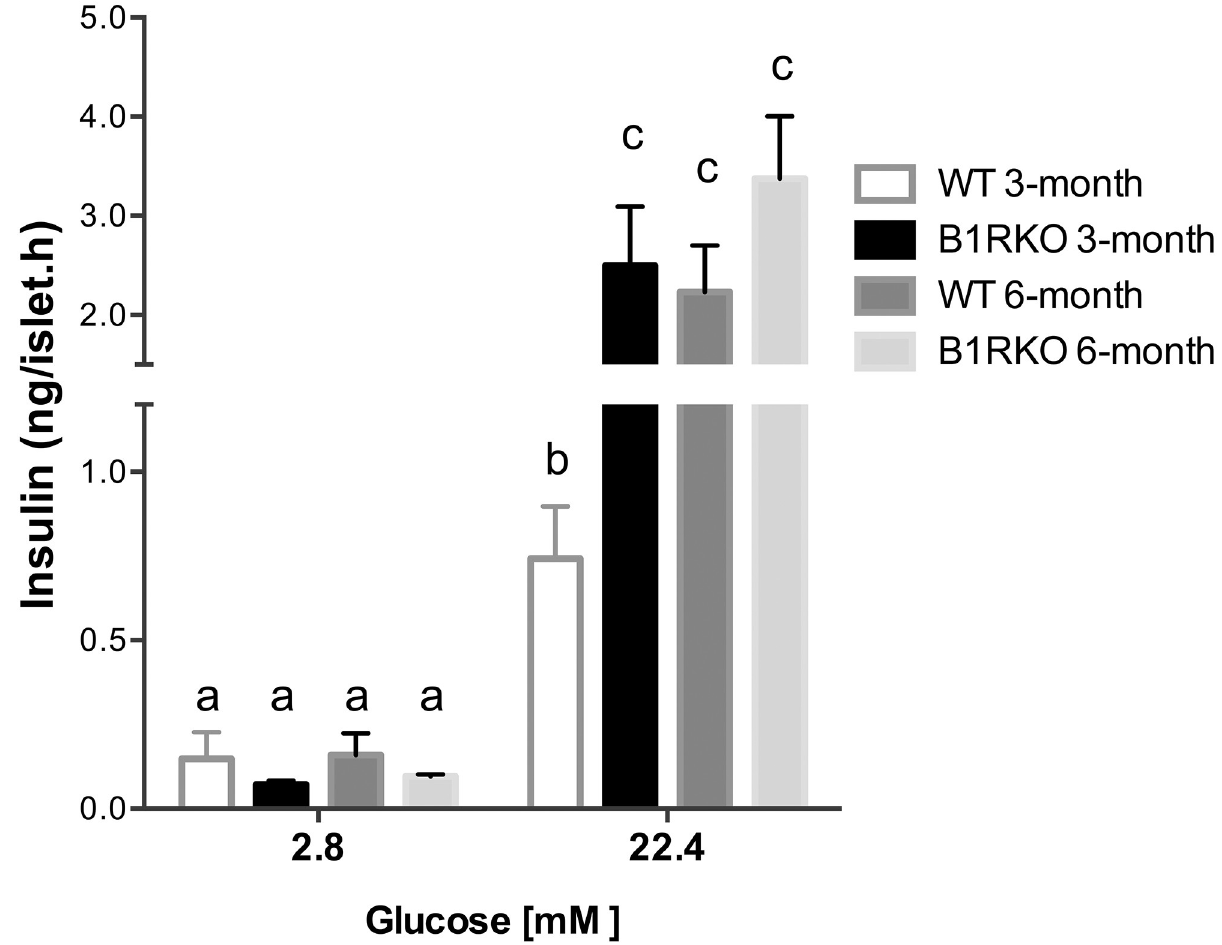
Fig 3. Insulin secretion in isolated islets. B1RKO and WT mice aging 3- and 6-months and fed only by SD were used to pancreatic islets isolation. Triplicates of 10 pancreatic islets from the same animal formed one experimental unit, which was repeated for each concentration. We used 4 animals of each genotype and age. Islets from 3-months old B1RKO showed an increasing insulin secretion if stimulated with high glucose concentration (22.4 mM) compared to the WT controls b . No difference was observed in low glucose concentration (2.8 mM) nor in older mice in the high glucose concentration. P-value tested by two-way ANOVA followed by Bonferroni post-hoc test. Different letters indicate differences in post-hoc test. WT, wild-type mice; B1RKO, B1R knockout mice; SD, standard diet; n =